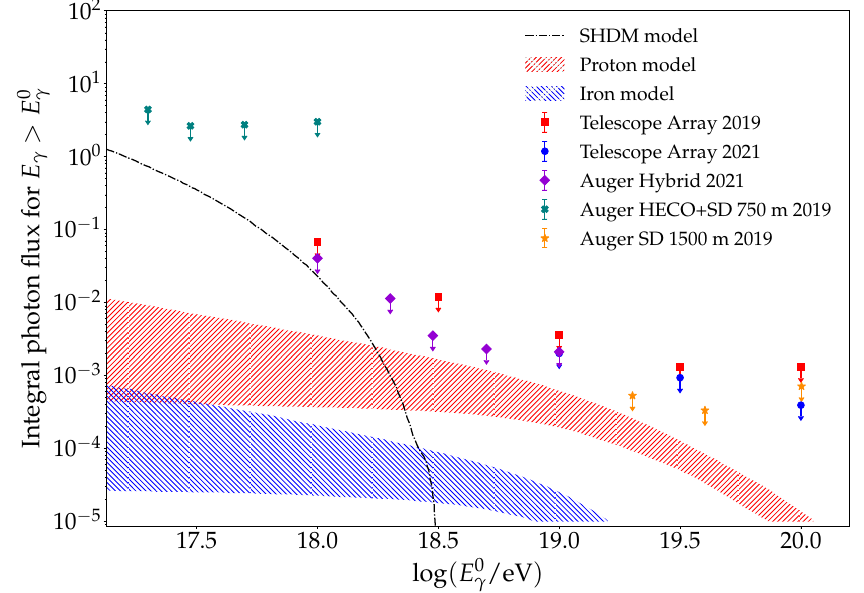
Figure 12. Upper limits on the integral photon flux at 95% confidence level obtained by Auger [103,104] and Telescope Array [105,106]. The shaded regions correspond two models in which the ultra- high-energy cosmic rays are dominated by protons and iron nuclei [14]. The dashed-dotted curve corresponds to the integral photon flux originated by the decay of hypothetical super-heavy dark matter particles of mass M χ = 10 10 GeV/c 2 and lifetime τ χ = 3 10 23 year [107]. Adapted from ×